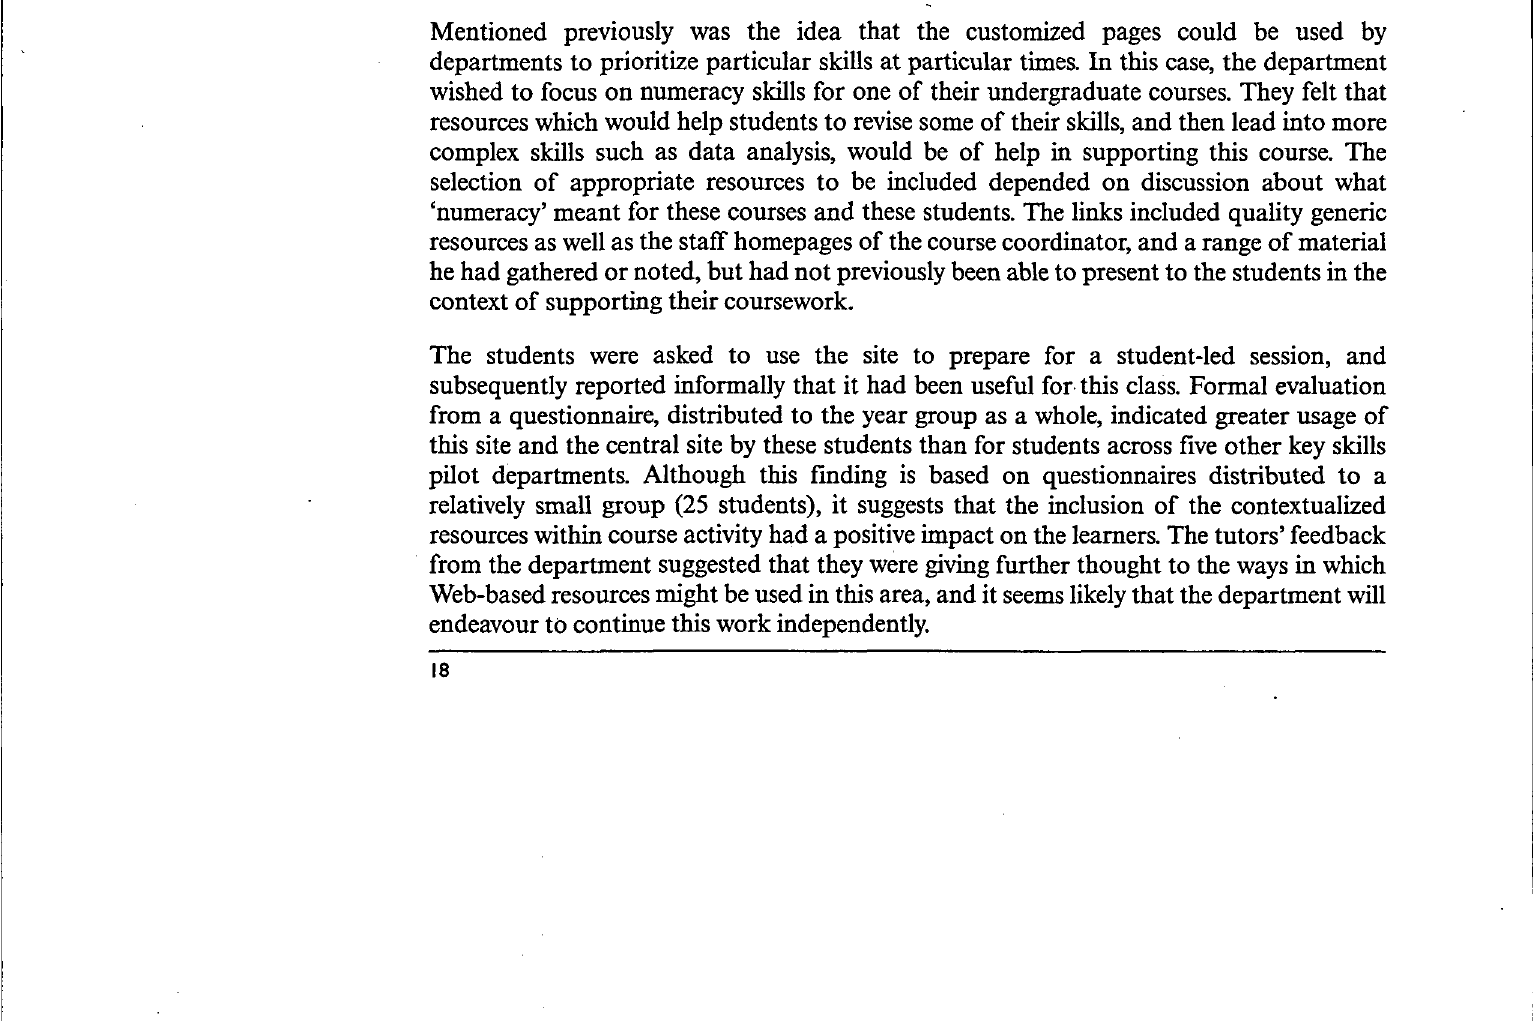
Figure 3: The main key skills